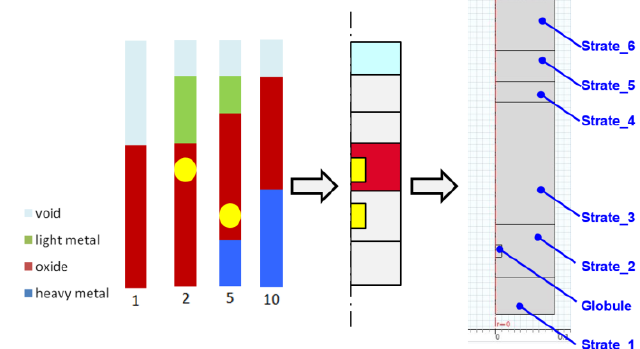
Fig. 5. .Relevant volumes inside the melted corium